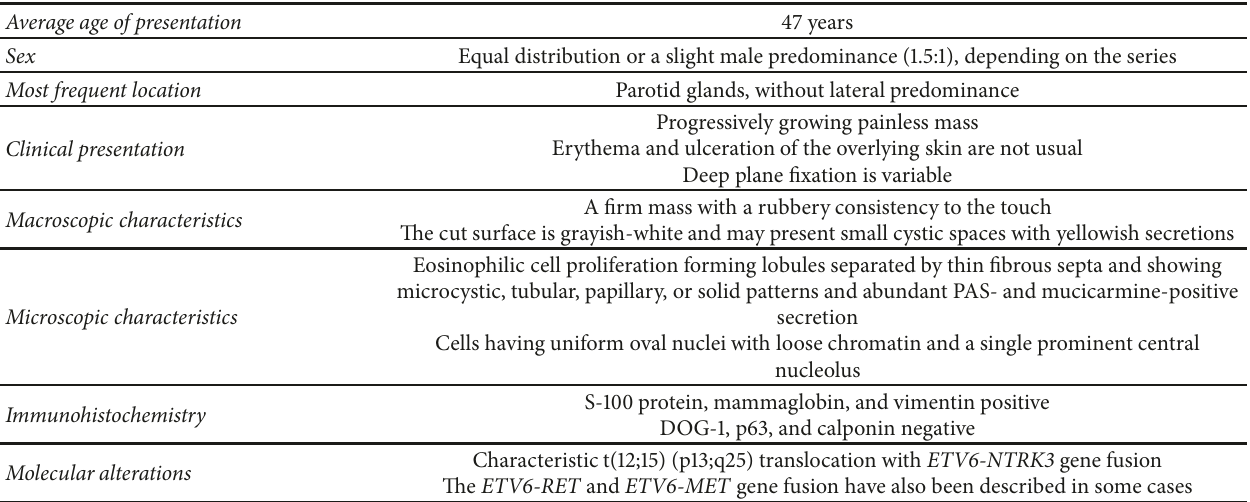
Table 1: Clinicopathological characteristics of secretory